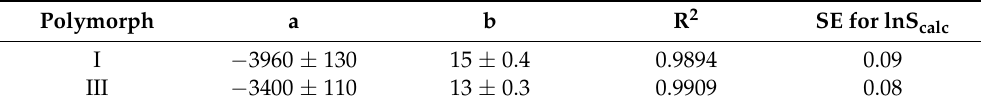
Table 1. Coefficients of the van’t Hoff equation for solubility curves of 2,6MeOBA polymorphs in pure water.